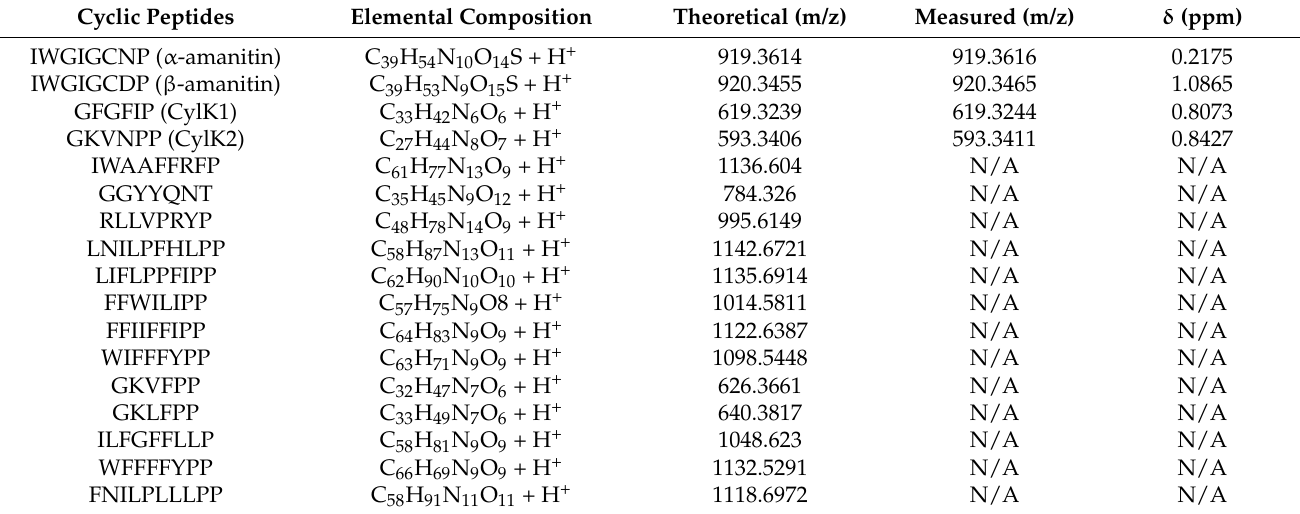
Table 2. Theoretical and measured molecular masses of cyclic peptides in Amanita molliuscula. Cyclic